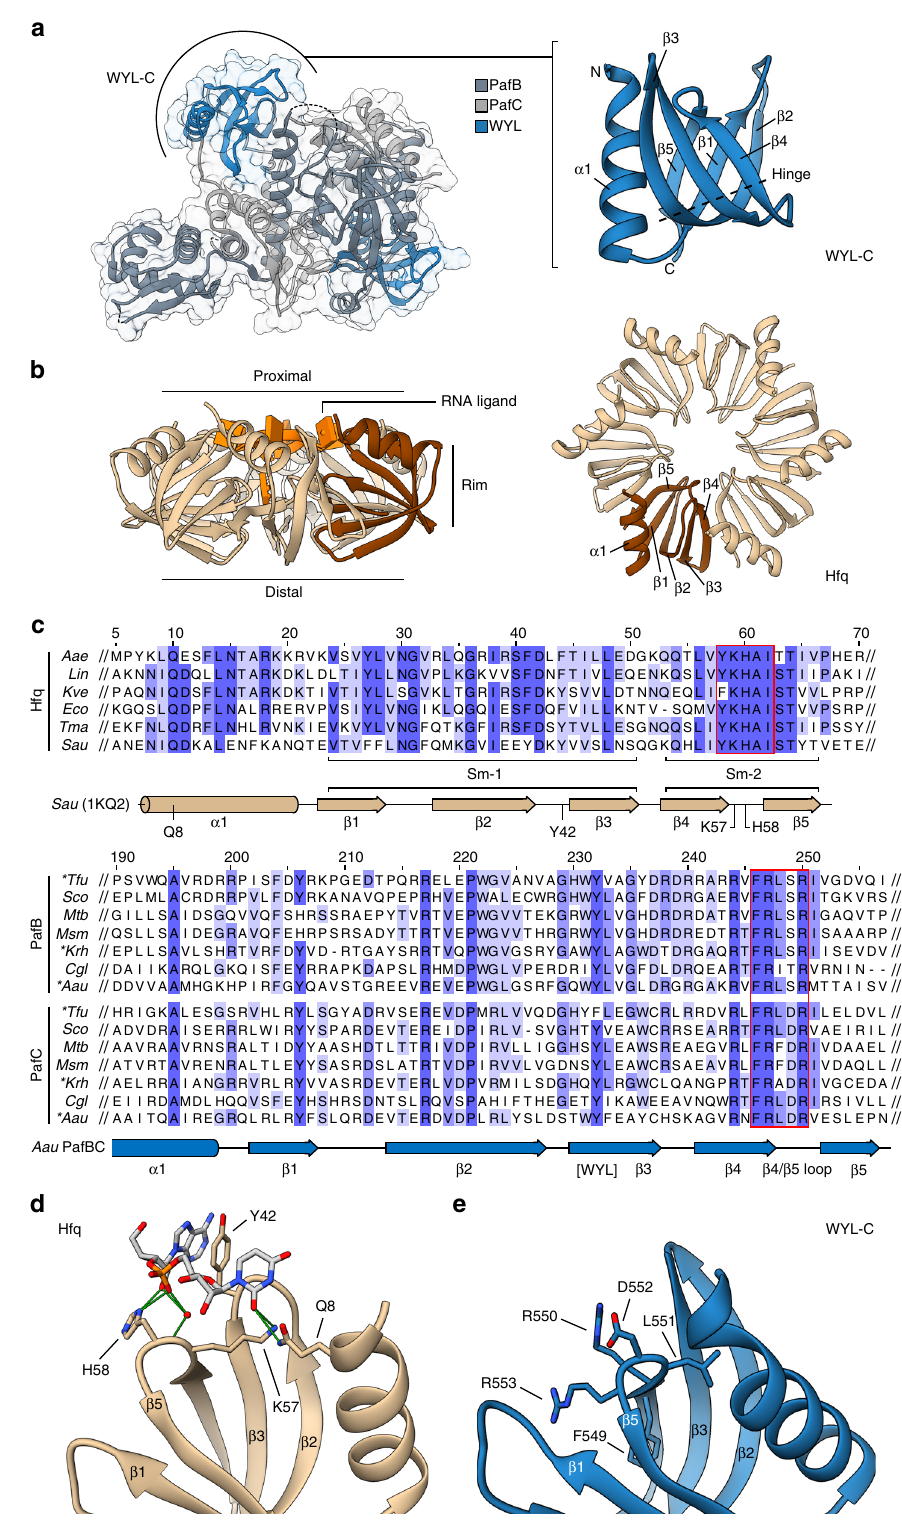
We then tested the alanine point mutants for complementa- tion. All 15 mutants, with the exception of double mutant B- F210A/C-F200A, exhibited similar PafBC expression levels to the wild type strain (Supplementary Fig. 8 and Supplementary Fig. 9b). The level of B-F210A/C-F200A was barely detectable, which could be either because the level is too low for detection and thus may not be suf fi cient for complementation or